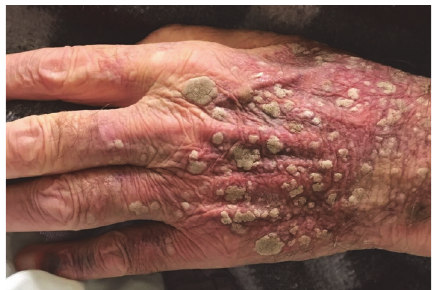
Figure 3: Remaining lesions on the back of the hand nine months after the start of the